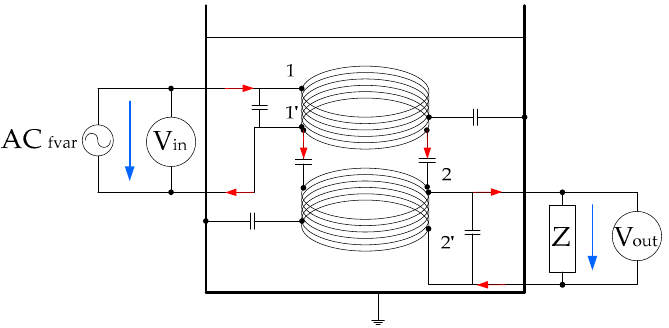
Figure 2. Frequency response analysis (FRA) test fluid core dual-coil sensor capacity couplings simplified circuit.